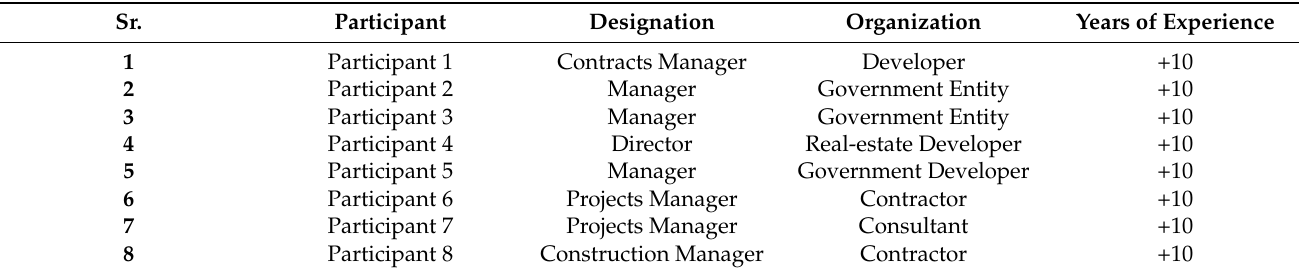
Table 7. Risk evaluation